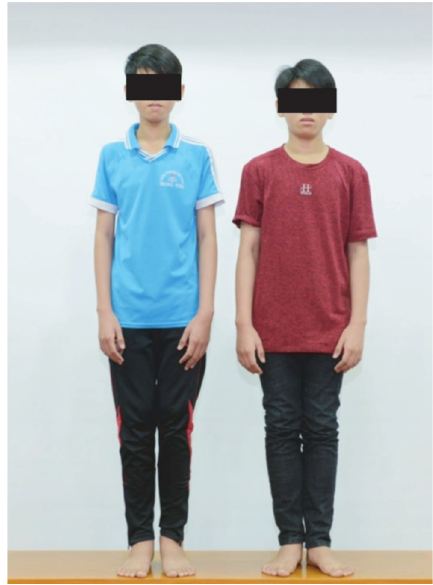
Figure 1: The patient (left) did not gain weight as well as his monozygotic twin brother (right).